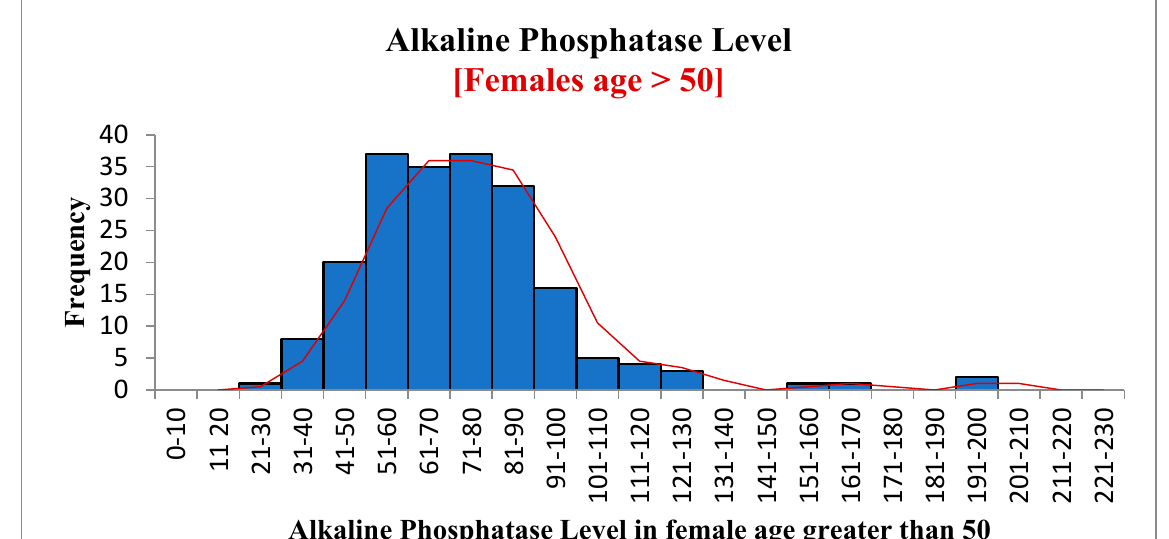
Figure 5. Alkaline phosphates in females aged 20–50.